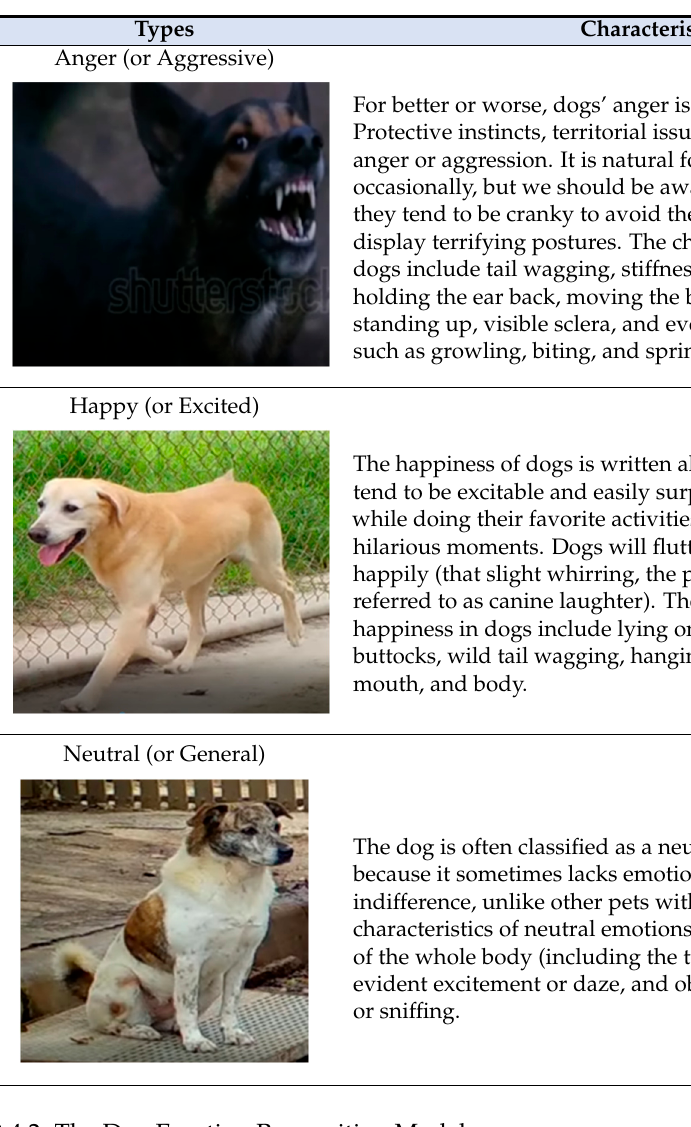
Table 1. The descriptions and characteristics of the three emotional types of dogs.